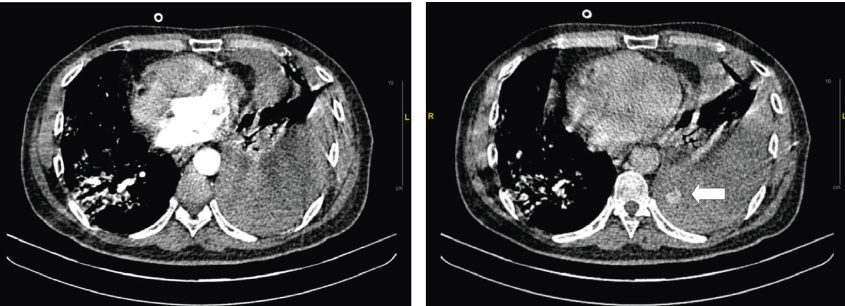
Figure 3: CTangiography of the thorax demonstrating a streak of contrast extravasation arising from 4 th intercostal space on portovenous phase with further pooling of contrast into pleural cavity at a 3-minute delayed phase (shown by the arrow).